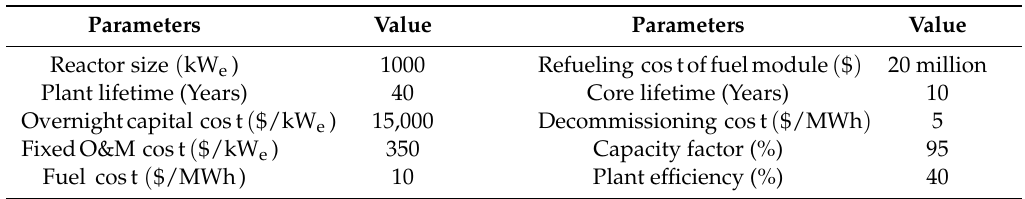
Table 2. Specifications of the